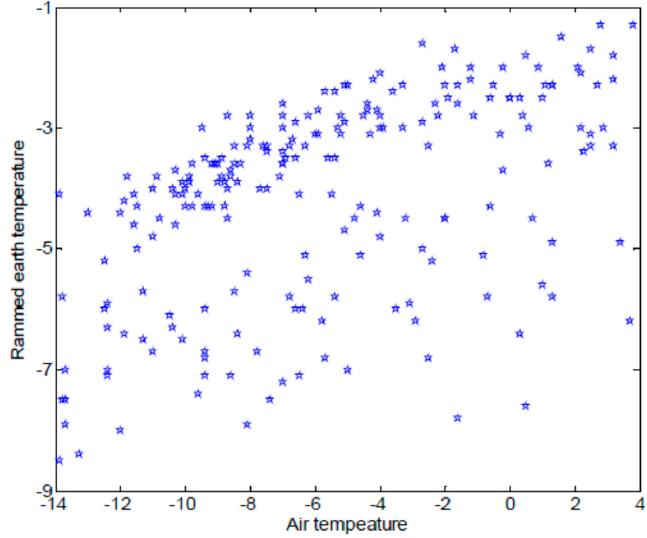
Figure 3. Relationship of the air temperature and the rammed earth temperature in Ming Dynasty Great Wall dataset.